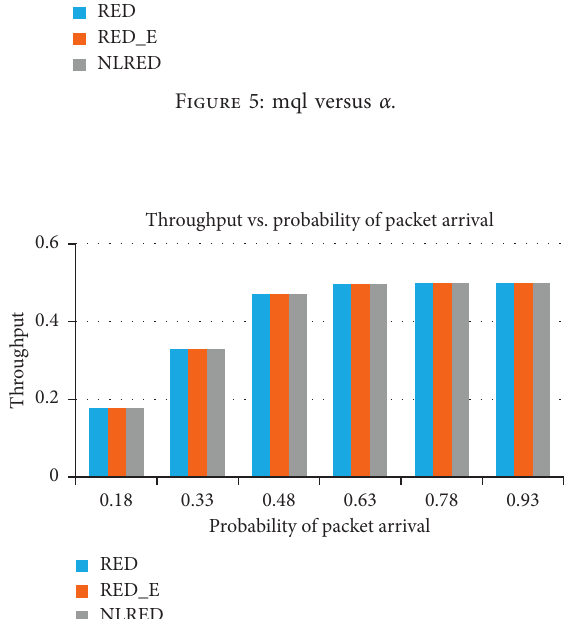
Figure 6: T versus α .